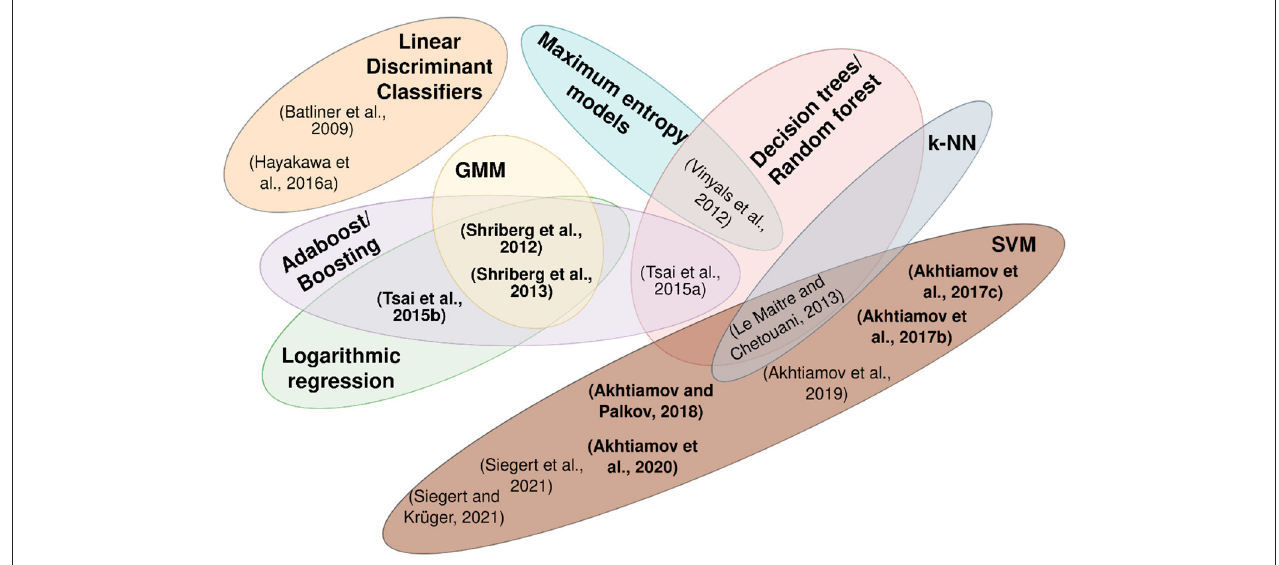
FIGURE 4 | Venn Diagram to illustrate the use of different classical classification architectures in the identified studies. Studies in bold employ a meta-classifier.